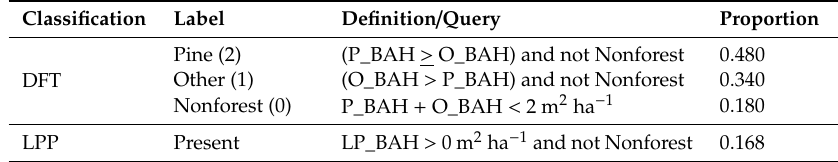
Table 1. Definitions and queries used to label Pine, Other, and Nonforest dominant forest cover types (DFT) and the presence of longleaf pine (LPP) along with proportions of plots meeting those criteria. Species composition for Pine and Other class labels can be found in Table